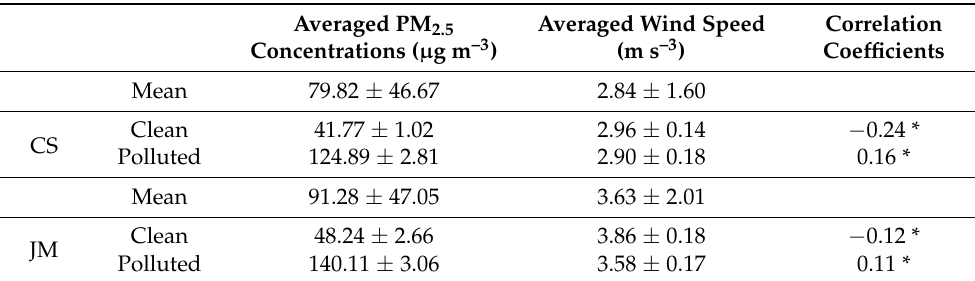
Table 2. Averaged PM 2.5 concentrations and wind speed (expressed as mean ± standard deviation), as well as their correlation coefficients under clean and polluted conditions in JM and CS for winters from